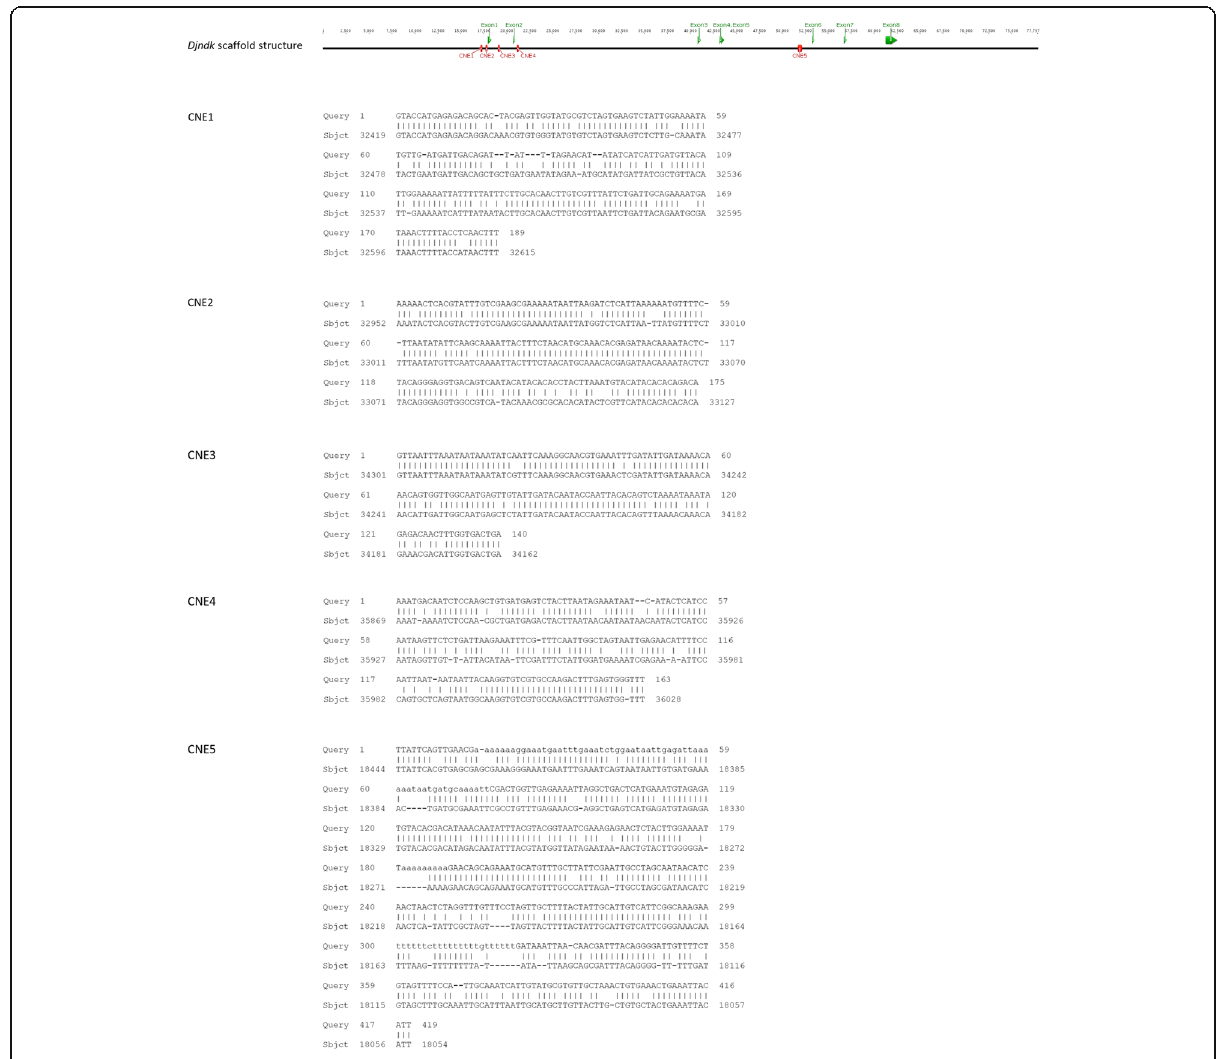
Fig. 6 Conserved non-coding elements between D. japonica and S.